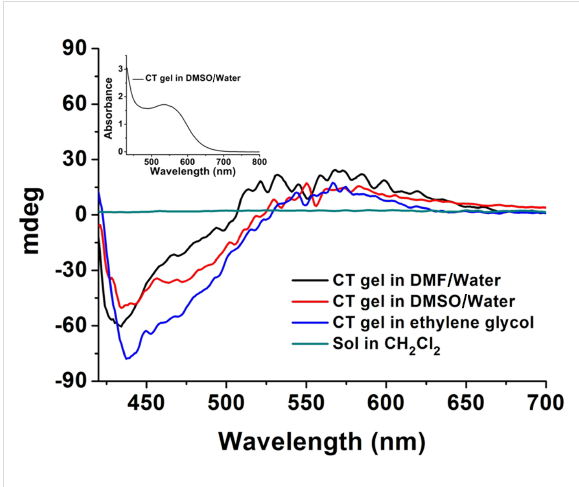
Figure 6: CD spectra of sol in CH 2 Cl 2 , and CT gel obtained from DMF/ water (3:1, v/v), DMSO/water (3:1, v/v), and ethylene glycol ( 3 and 4 , 1:1, molar ratio, [ 3 ] = 12 mM); inset graph: UV–vis spectrum of CT gel in DMSO/water (3:1,